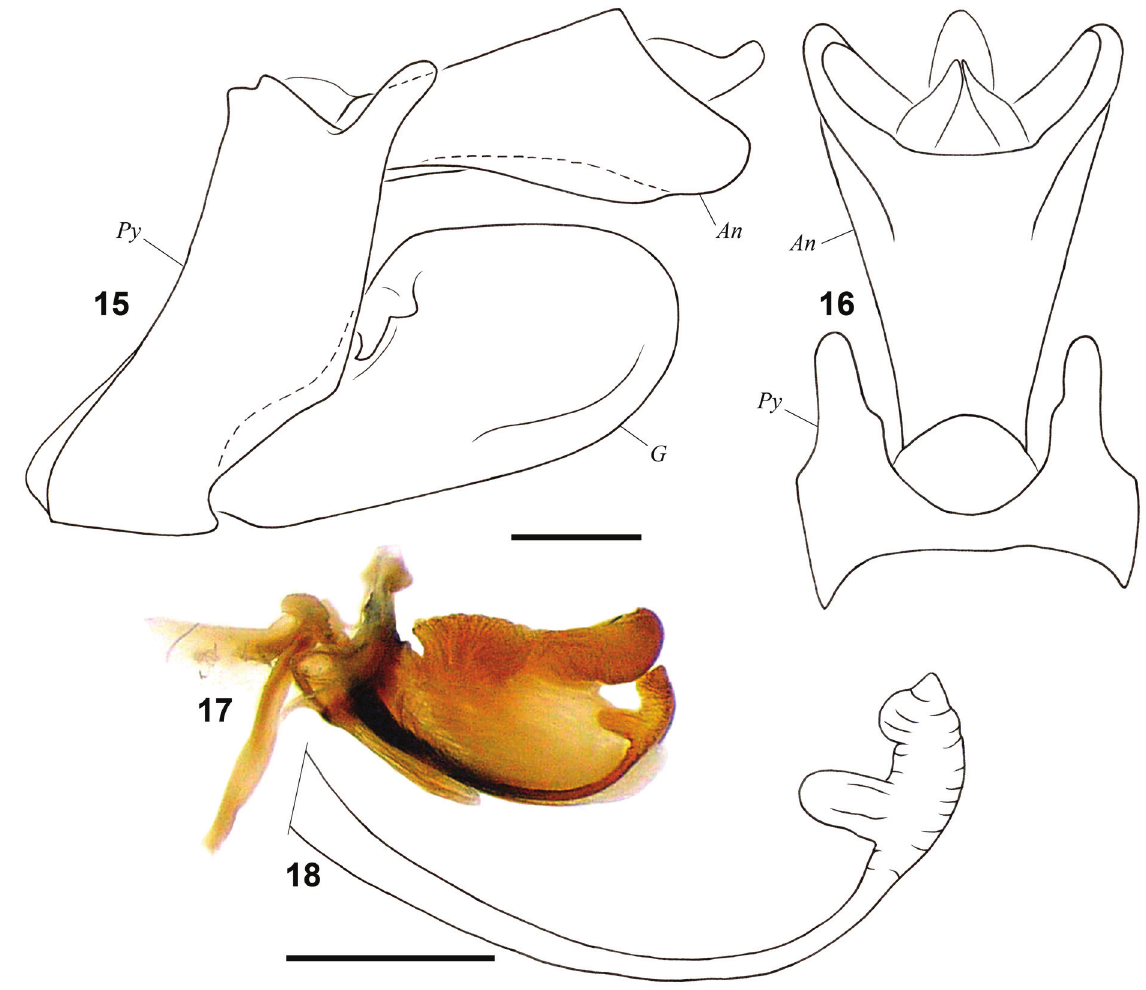
and gonostylus: left lateral view. 16 . Pygofer and anal tube: dorsal view. 17 . Phallic complex: left lateral view. 18 . Latero-ventral sclerotized process of phallic complex, left lateral view. An = anal tube, G